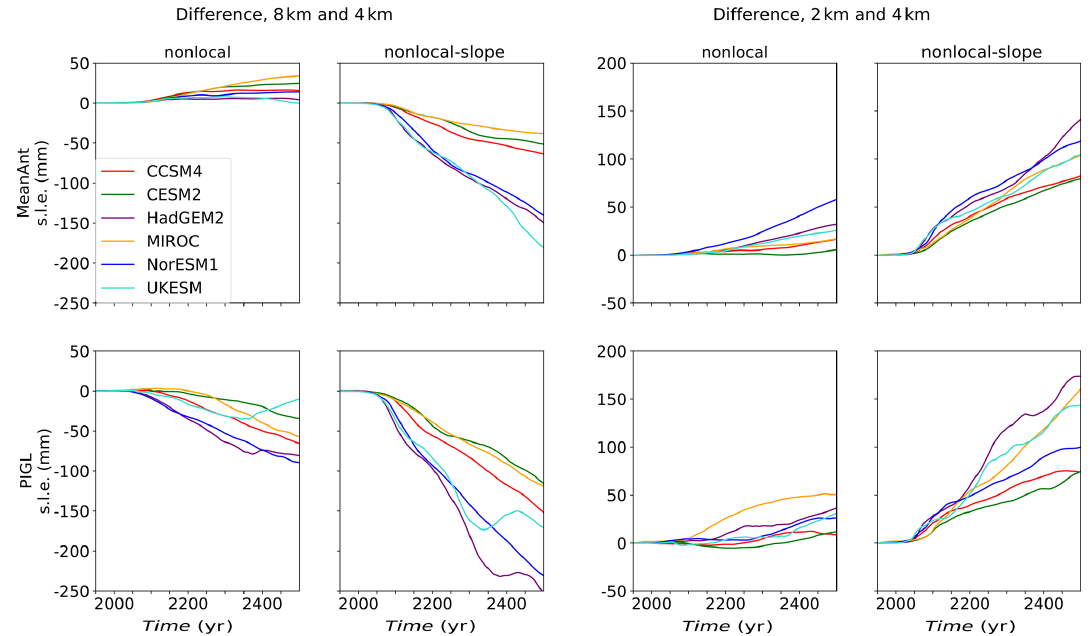
Figure 13. Difference in SLR contribution (mms.l.e.) during 550-year projection experiments, as a function of grid resolution. The four left- hand panels show differences between 8 and 4km runs, and the four right-hand panels show differences between 2 and 4km runs. Positive values indicate a greater SLR contribution on the non-standard grid (8 or 2km). The four panels at each resolution correspond to the nonlocal and nonlocal-slope melt parameterizations with the MeanAnt and PIGL calibrations.